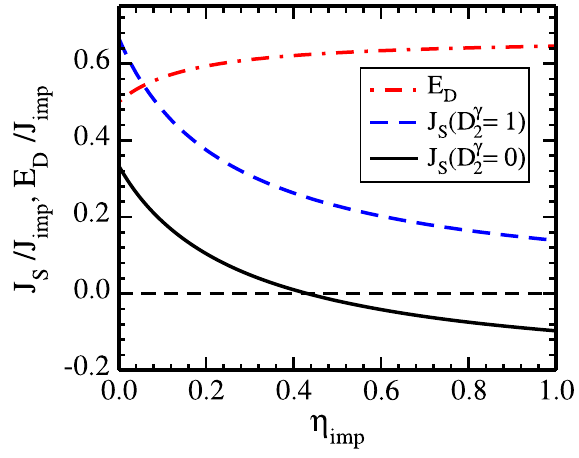
γ Þ D ð 2 Þ and the S ð γ , so D ≲ 0 . 43 or FM imp